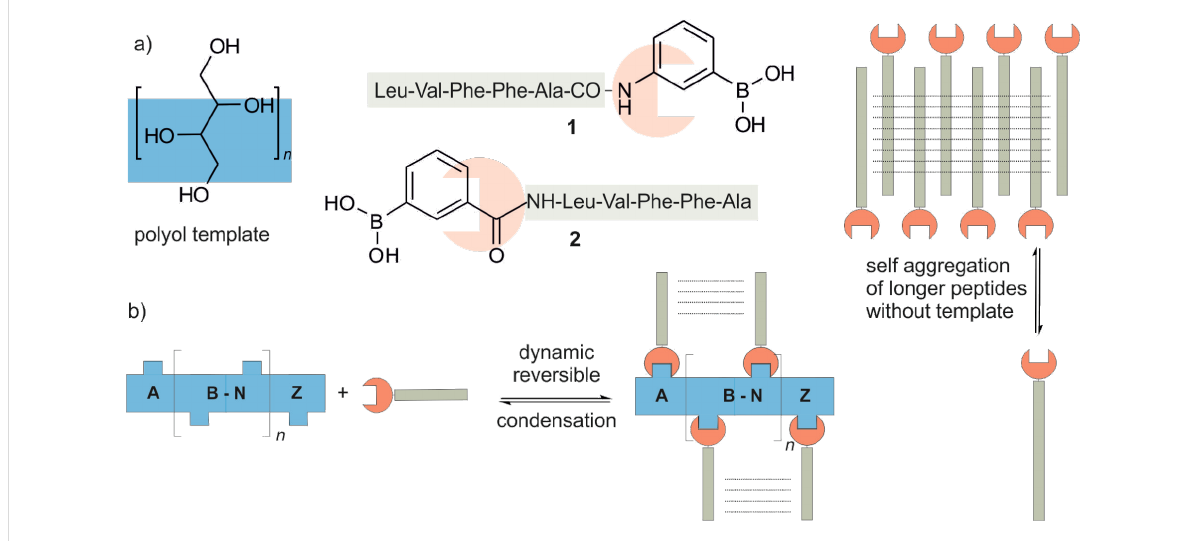
Figure 2: a) Peptide boronic acids 1 and 2 are schematically shown as green sticks (peptide) with a red gripper (boronic acid) and the template is blue. The peptide must be short enough to prevent the fibrillation shown on the right. b) Non-covalent interactions between neighboring peptides on the template support esterification. The fine tuning of A β aggregation is performed by tailoring the peptide length to match the template size.